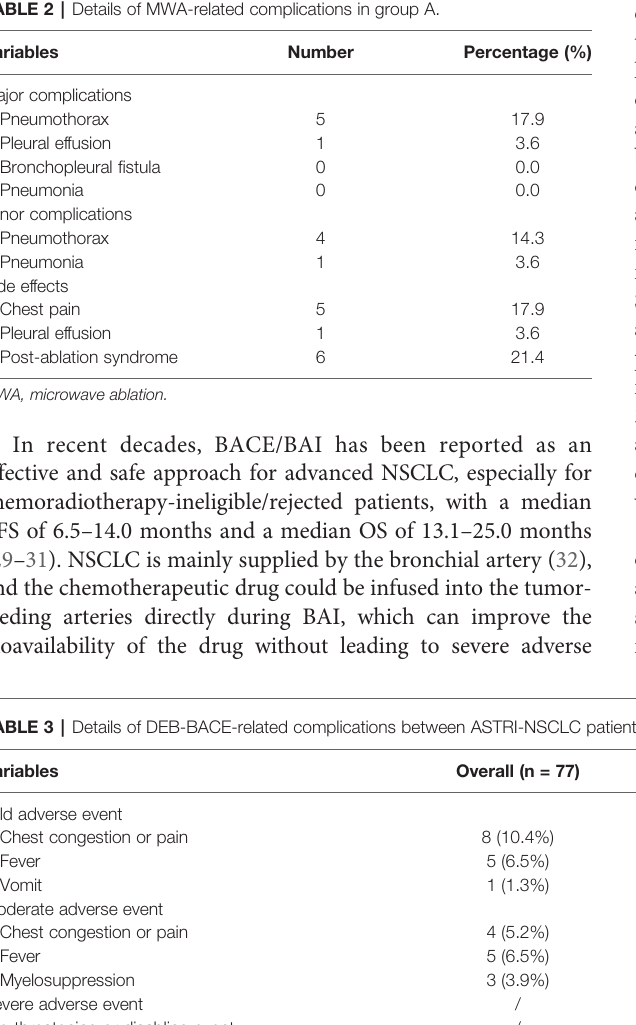
Chest congestion or pain